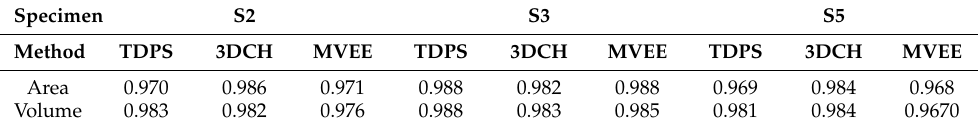
Table 1. The goodness-of-fit R 2 of area and volume.